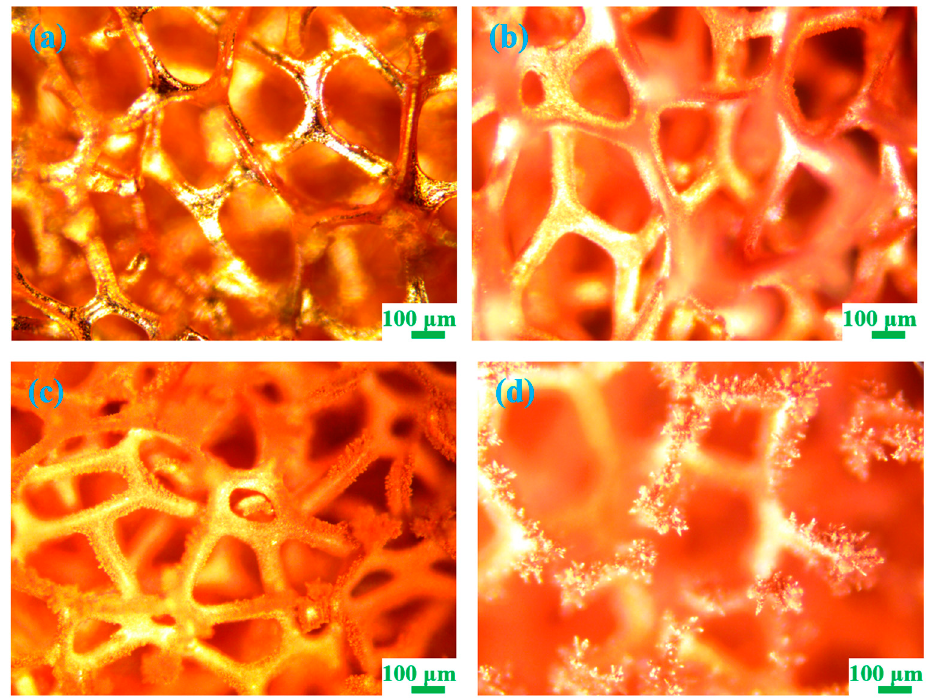
Figure 3. Microscopy images of samples ( a ) CF#0s, ( b ) CF#195s, ( c ) CF#255s, and ( d ) CF#300s.